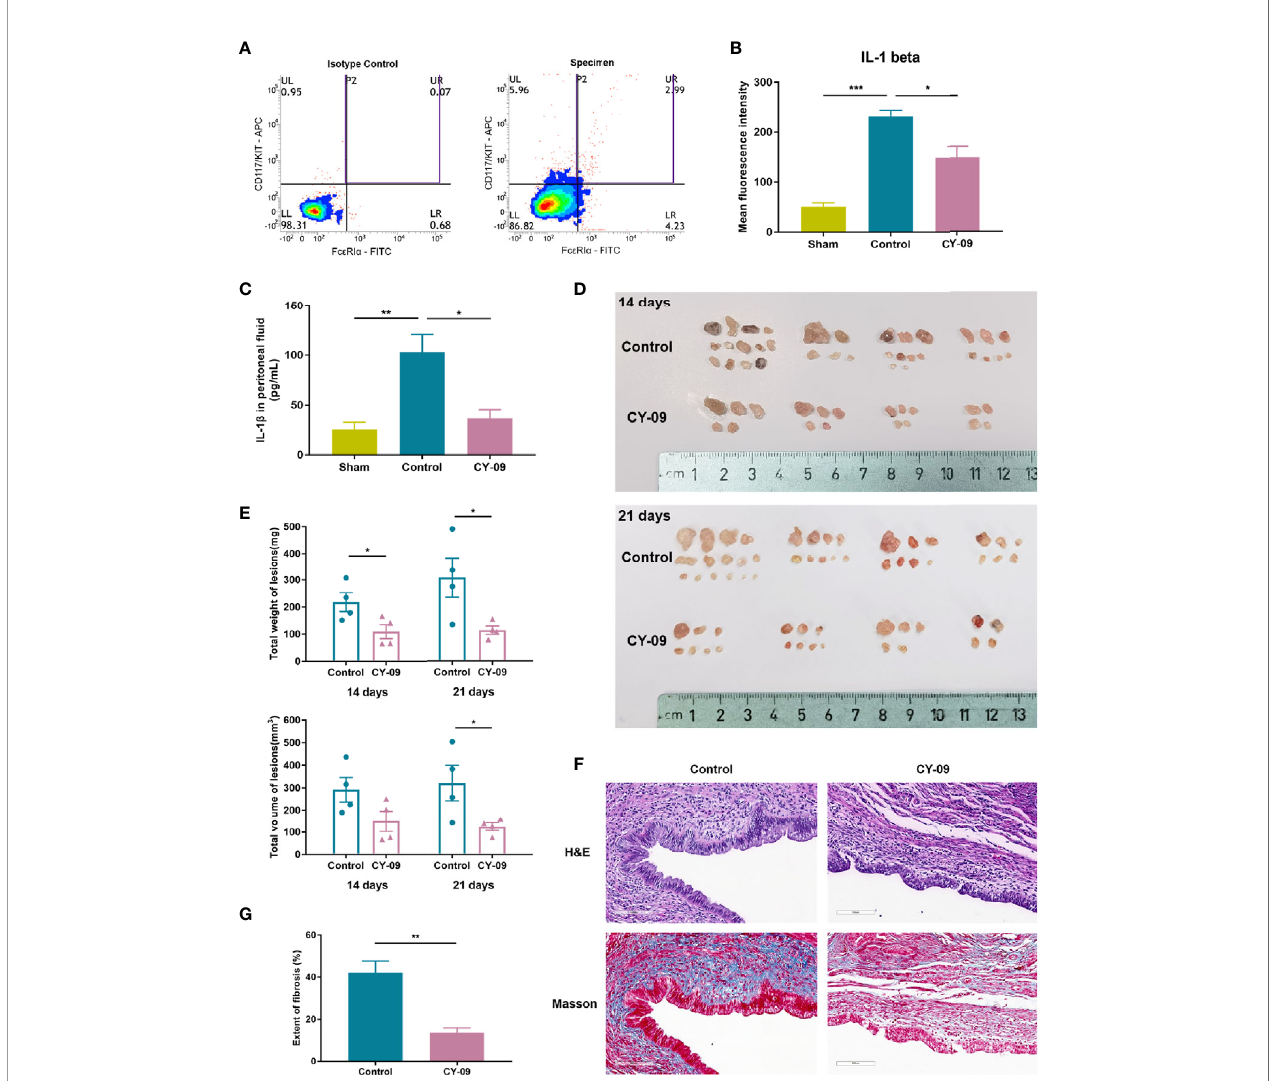
FIGURE 6 | NLRP3 inhibitor CY-09 treatment suppressed the development of endometriotic lesions in mice. (A) Representative dot plot of cells in mouse peritoneal fl uids by fl ow cytometric analysis using CD117/c-KIT and Fc ϵ RI a staining. Mast cells were identi fi ed by double-positive expression of CD117 and Fc ϵ RI a . (B) Peritoneal cells were stained for IL-1 b , and the MFI of IL-1 b in selected mast cells was analyzed by fl ow cytometric analysis. (C) The concentration of IL-1 b in the peritoneal fl uid of mice was tested using ELISA (n = 4). (D) Gross morphology of endometriotic lesions from mice of different groups. (E) The total weight and volume of endometriotic lesions in the control and CY-09 administration groups were assessed on day 14 and 21. (F) Representative hematoxylin and eosin (H&E) and Masson ’ s trichrome staining results in ectopic lesions from mice of different groups on day 21. Scale bar = 100 m m. (G) Quanti fi ed results of the extent of fi brosis in different groups. Results in (B, C, E, G) are expressed as mean ± SEM (n = 4 in each group). Statistics: Unpaired Student ’ s t-test. * P < 0.05, ** P < 0.01, *** P <